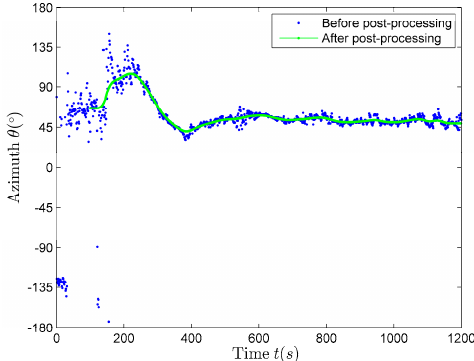
Figure 15. The estimation results of the azimuth before and after post-processing.